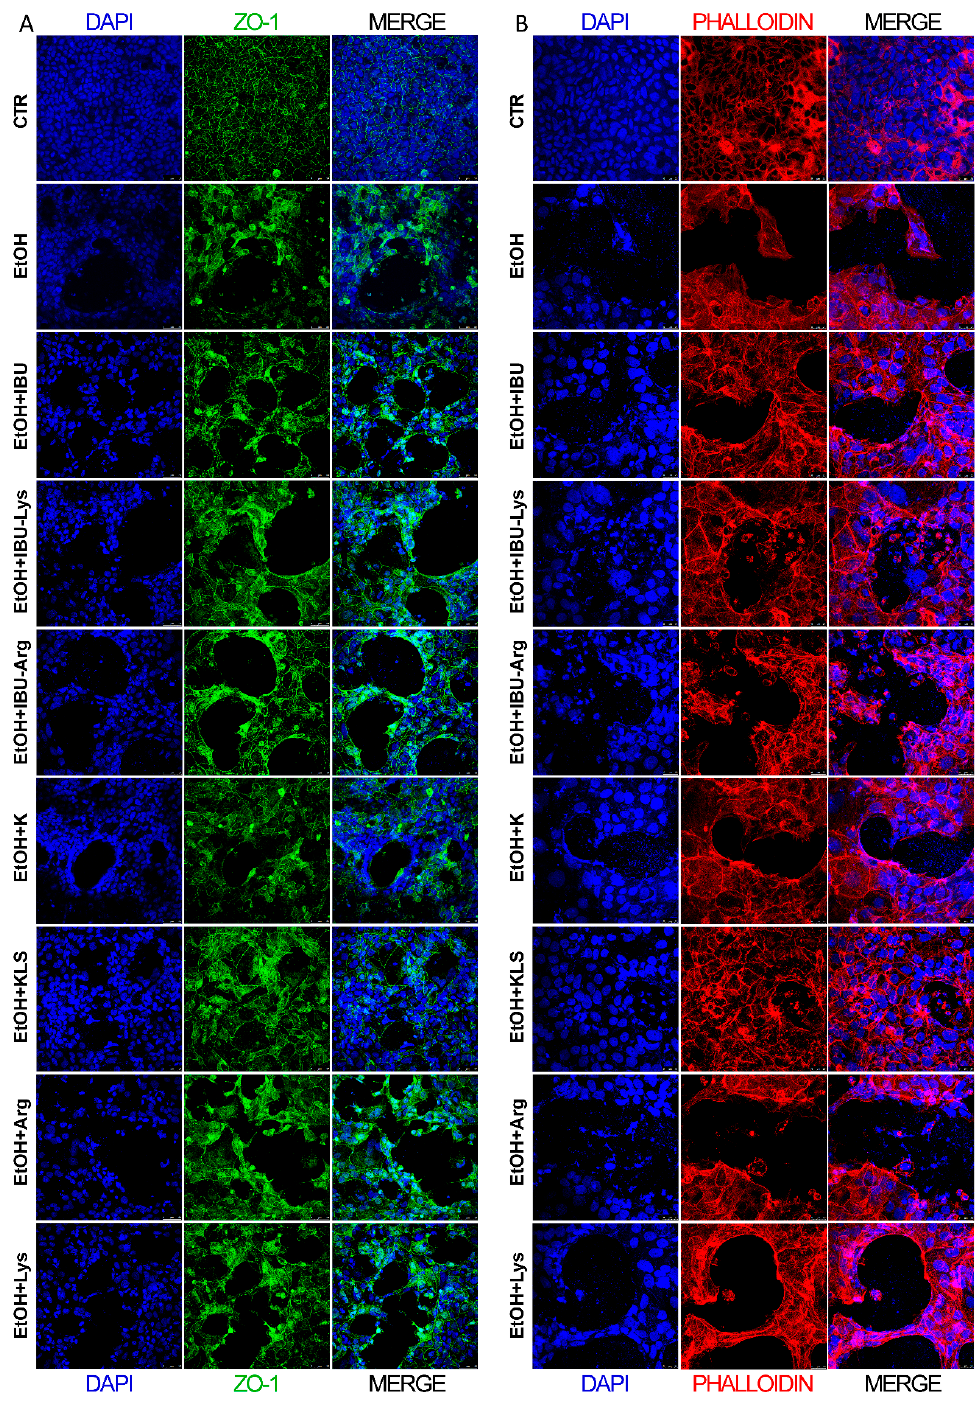
Figure 2. ( A ) Immunofluorescence of ZO-1 in Caco-2 cells after EtOH (6% for 24 h), EtOH + IBU, EtOH + IBU-Lys, EtOH + IBU-Arg, EtOH + K, EtOH + KLS, EtOH + Arg, and EtOH + Lys (1 mM) treatments for 72 h. ZO-1 (green), DAPI (nuclei, blue) Bar = 50 µm. ( B ) Immunofluorescence of phalloidin (red) staining in Caco-2 cells after EtOH (6% for 24 h), EtOH + IBU, EtOH + IBU-Lys, EtOH + IBU-Arg, EtOH + K, EtOH + KLS, EtOH + Arg, and EtOH + Lys (1 mM) treatments for 72 h. DAPI (nuclei, blue). Bar = 25 µ m. n = 3, 5 fields/slide were examined, and a representative picture is